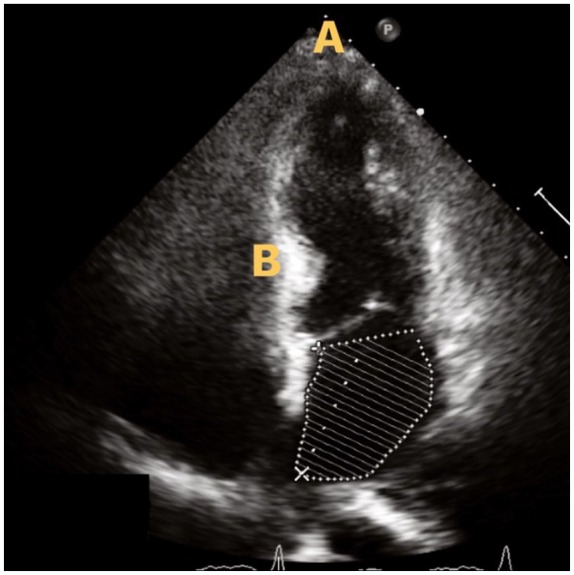
Echocardiogram reveals apical akinesis (A) and basal hyperkinesis (B)
consistent with takotsubo cardiomyopathy.